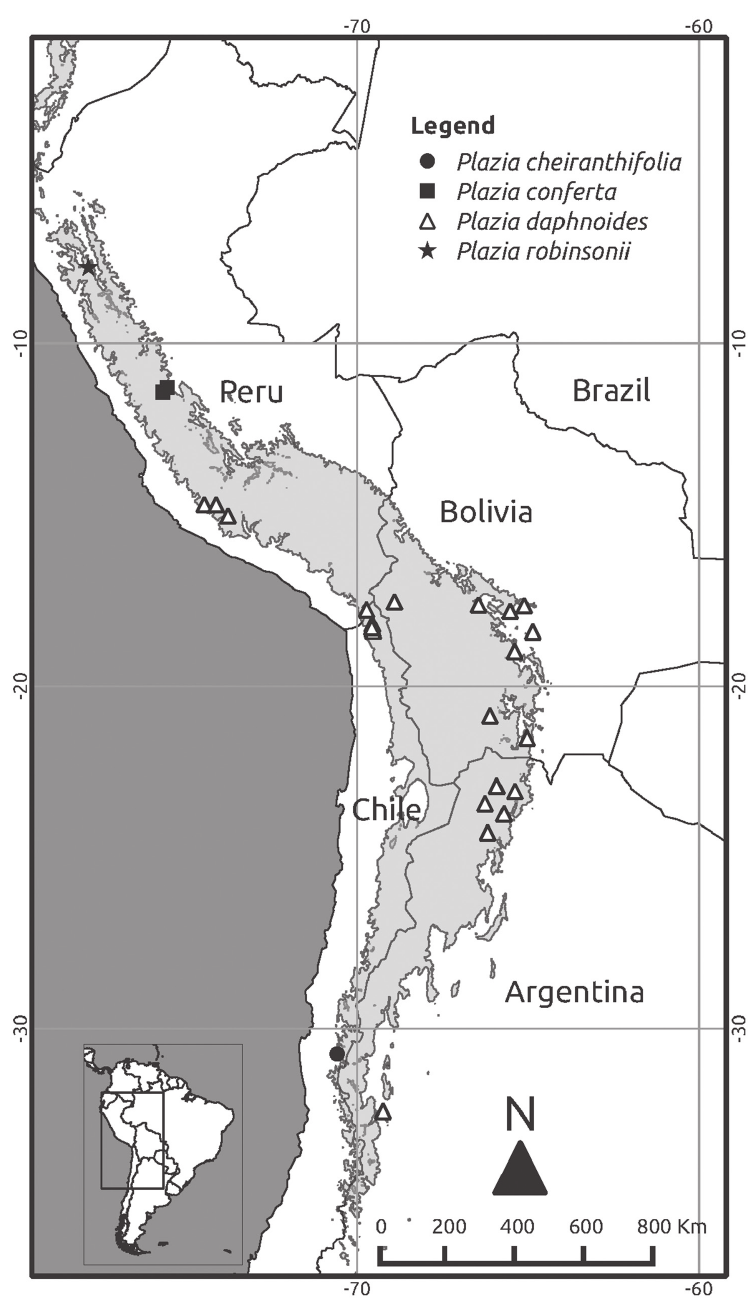
Figure 1. Distribution map of the currently recognized species of Plazia . The shaded area indicates high-elevation areas of the Andes above 3000 m. Locality data were obtained from Cabrera (1951), Fer- reyra (1995), Missouri Botanical Garden (http://www.tropicos.org/), Instituto de Botánica Darwinion (through http://www.gbif.org/) and the herbaria ASU, B, F, HUT, P, SGO,